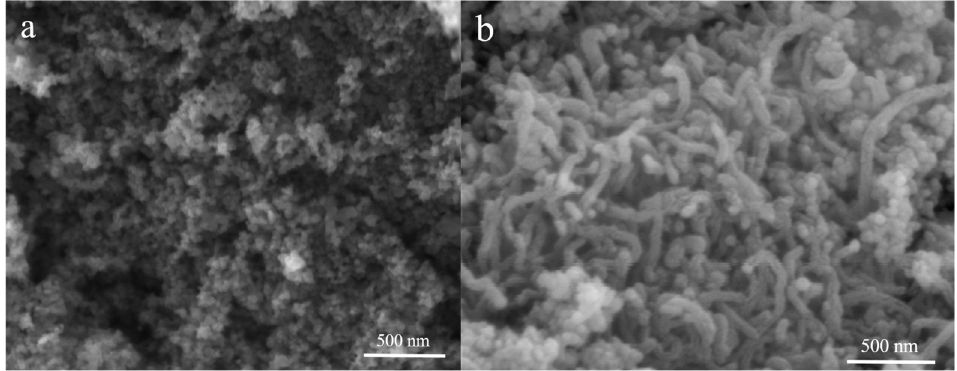
Figure 1. SEM micro-morphologies of the TiO 2 ( a ) and TiO 2 /CNT ( b ) mesoporous nanomaterials.